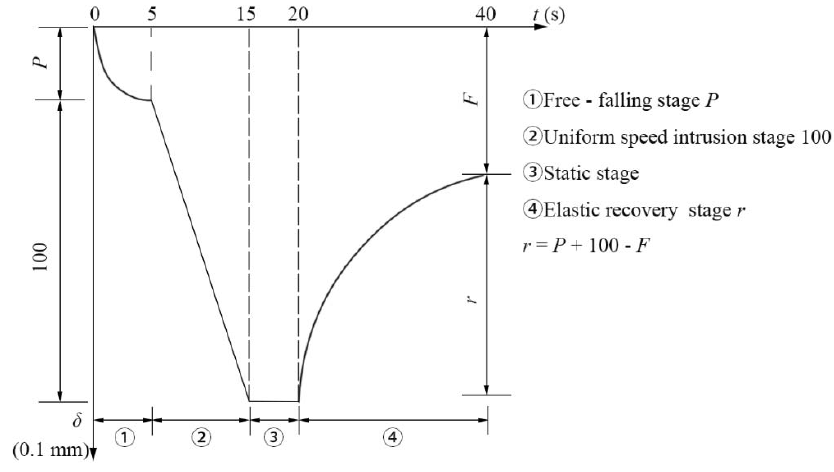
Figure 4. Schematic diagram of elastic recovery rate test process.